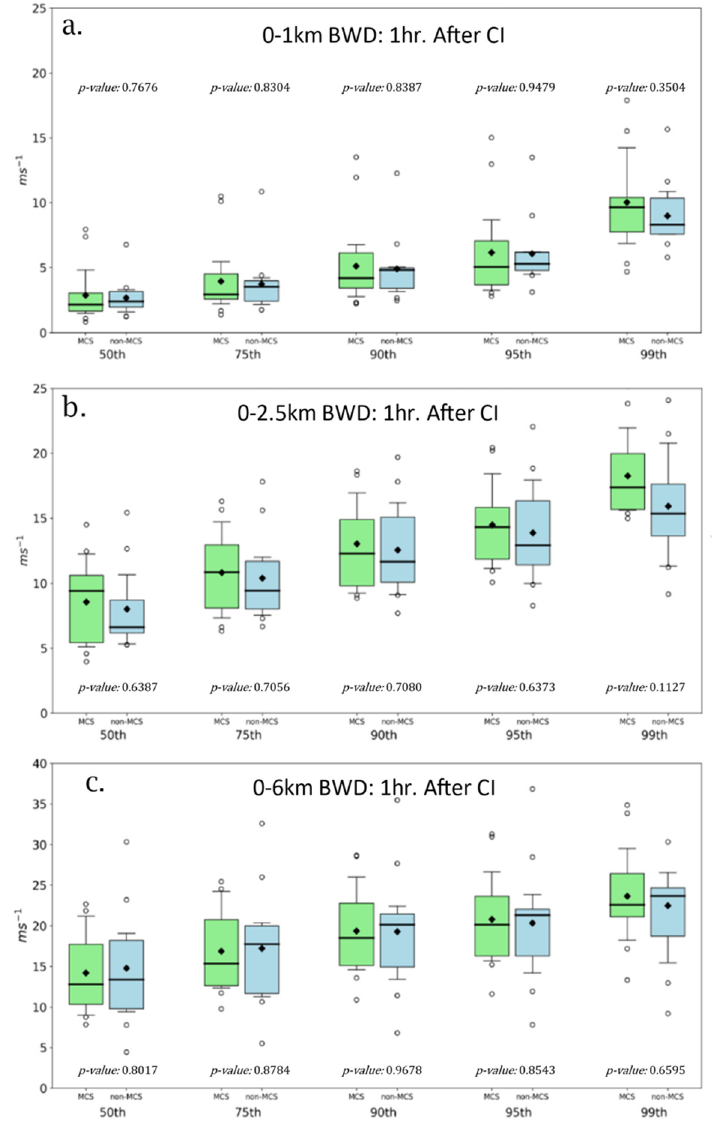
Figure 5. As in Figure 2, but for ( a ) 0–1-km, ( b ) 0–2.5-km, and ( c ) 0–6-km bulk wind difference magnitude one hour after CI. Units in m s − 1 .